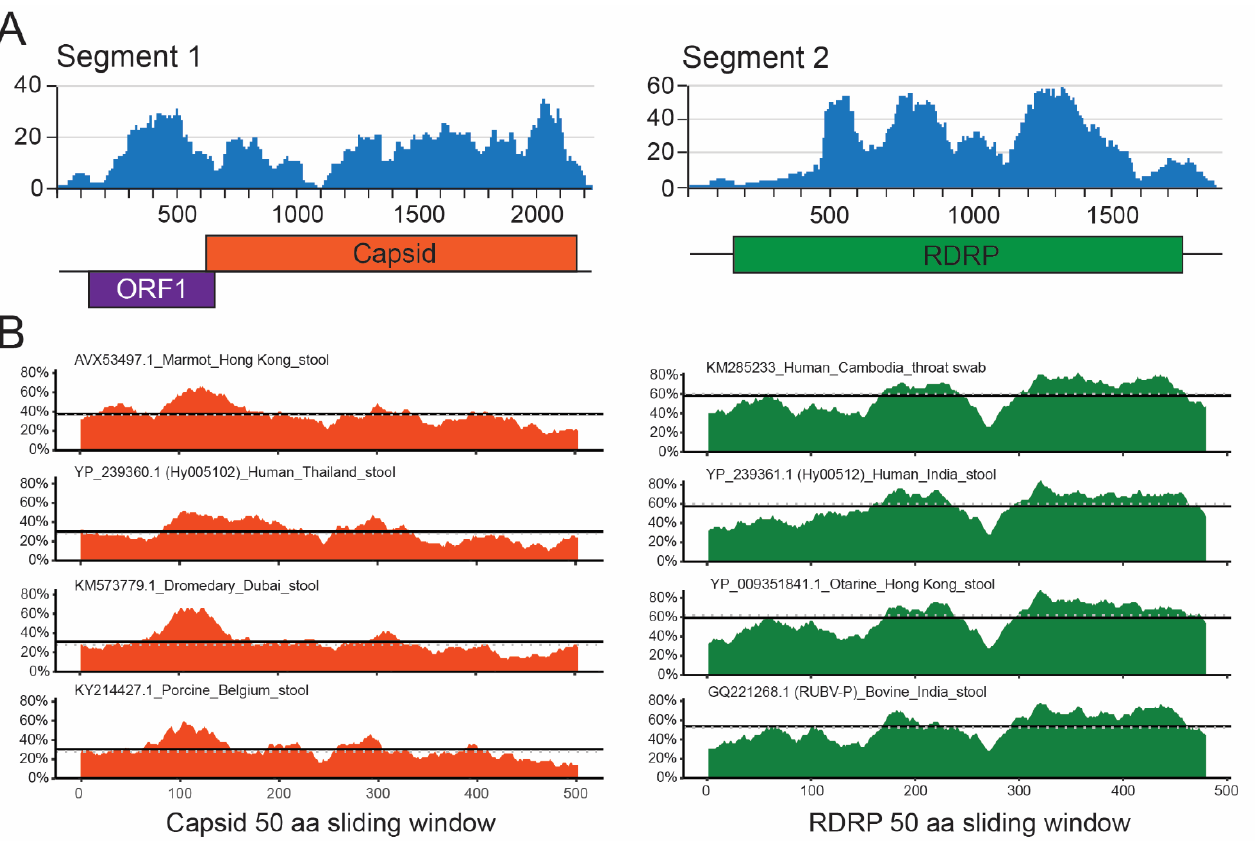
Figure 1. Discovery of a divergent PBV in a patient with acute respiratory illness. ( A ) Genome coverage plots of NGS data for segments 1 and 2. Segment 1 is approximately 2.5 kb long and encodes a hypothetical, hydrophilic protein (ORF1) of 168 aa and a 527 aa capsid protein in a separate reading frame. Segment 2 is approximately 1.7 kb long and encodes the 530 aa RdRp. ( B ) Pairwise amino acid alignment (50 aa sliding window) of the ABT3406 capsid (orange; left) and RdRp (green; right) with representative picobirnavirus strains. The mean (solid line) and median (dotted line) identities overall are approximately 35% and 60% for capsid and RdRp, respectively.